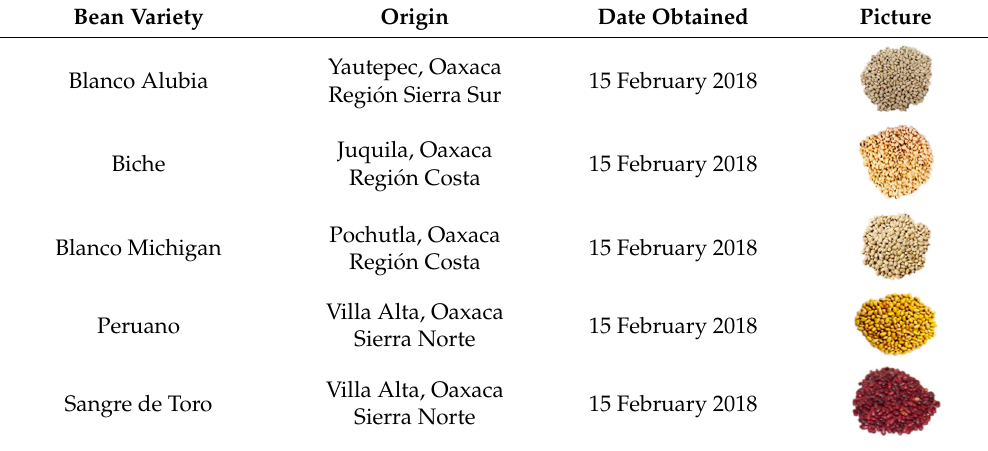
Table 1. Varieties of bean from the state of Oaxaca (Mexico).